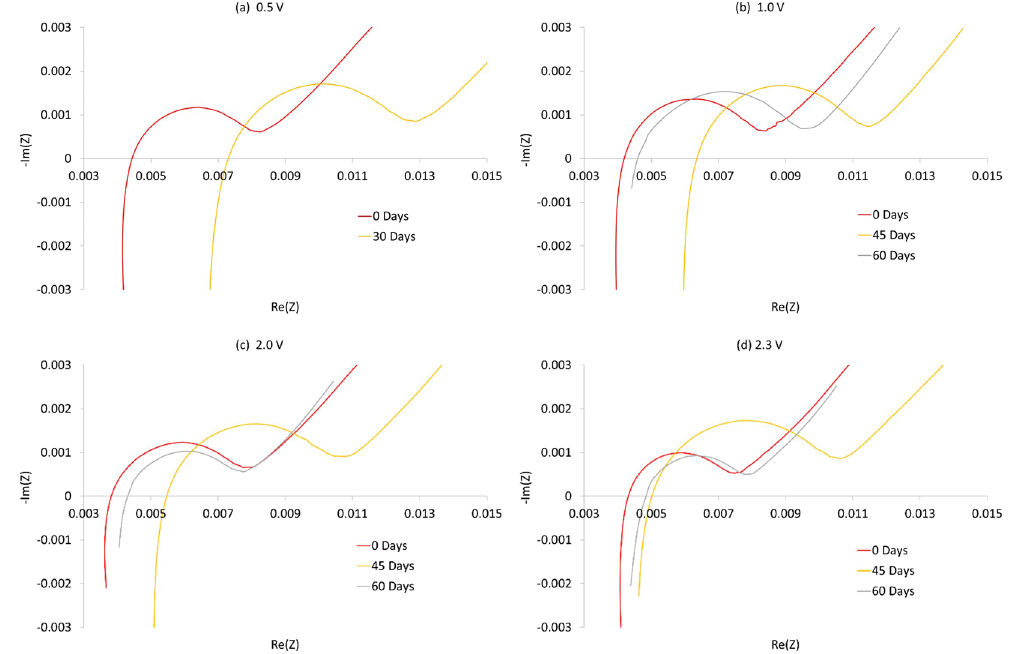
Figure 3. Change of impedance measured by EIS at 50% SoC. The x-axis has the real part of the complex impedance and y-axis has the imaginary part, both has unit of Ω